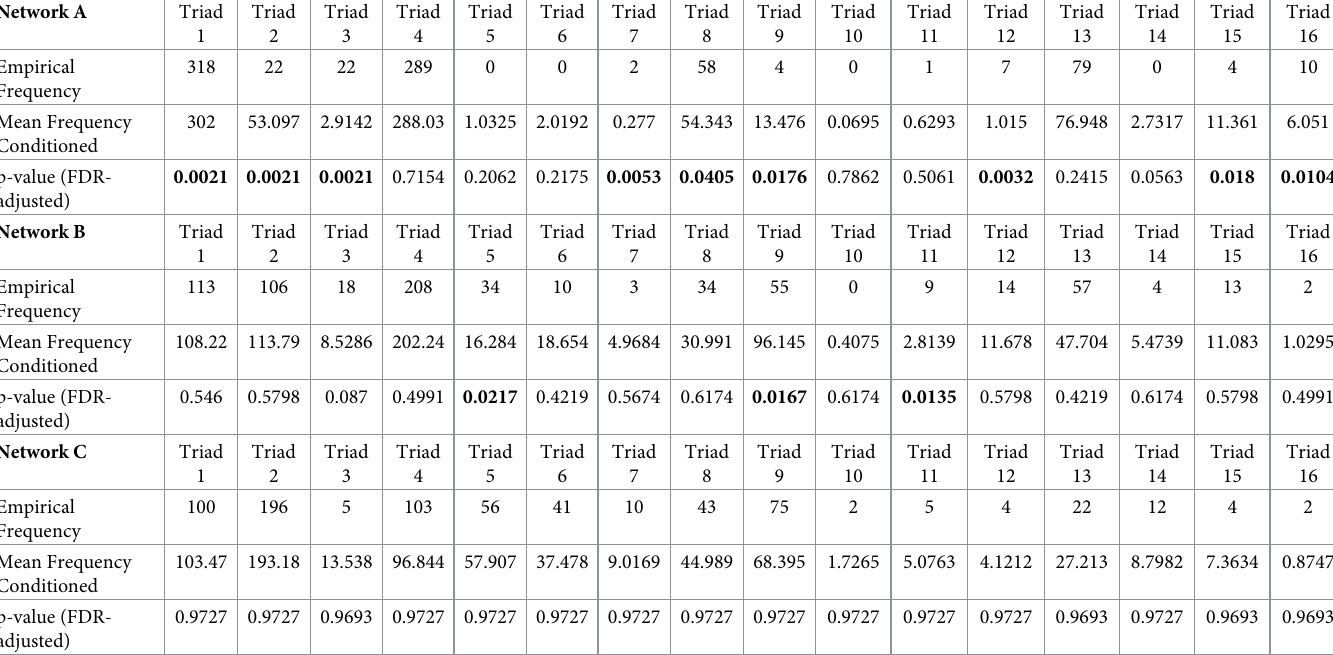
Table 2. Comparison of triad frequencies in empirical versus degree-conditioned random networks. P-values are based on z-tests comparing the empirical frequency of each triad to the expected value based on mean frequency in conditioned networks. Network